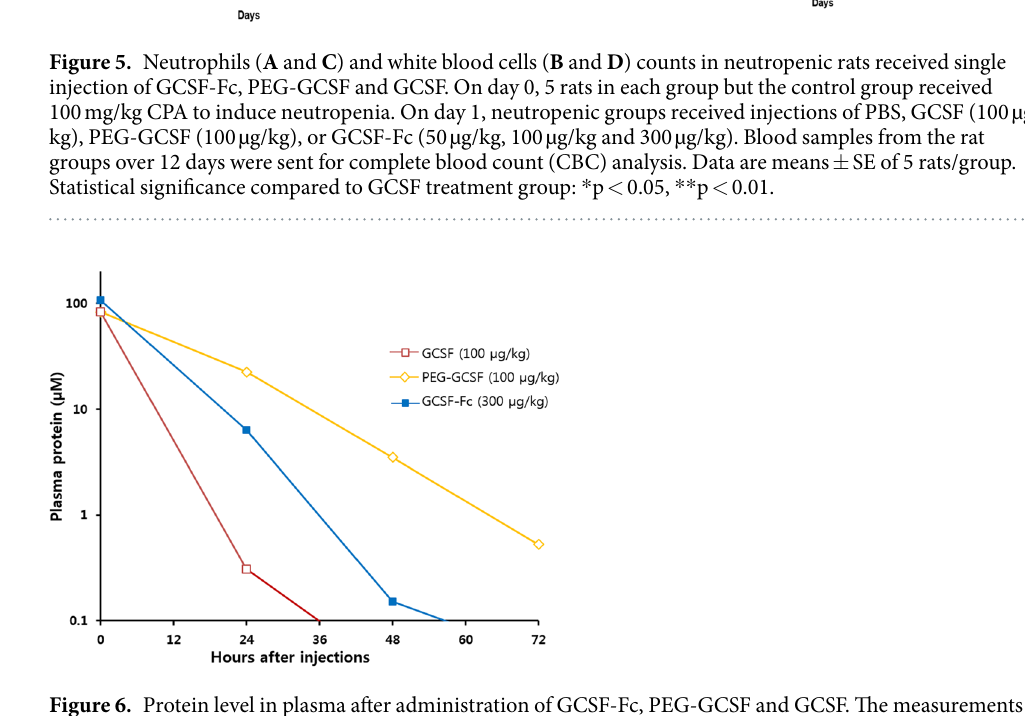
size, easy purification using MBP chromatography, and efficacy in supporting the expression as well as proper folding of target proteins in the reducing environment of E. coli cytoplasm, MBP is largely the tag of choice. For the expression of MBP-tagged GCSF-Fc, induction by 0.5 mM IPTG at 30°C for 5 h was the optimal condition for expression (Fig. 1B). Nearly 70% of this fusion protein was soluble and this maximized the purification process with only the protein A resin (Fig. 2A and B). When the Fc domain alone was expressed in E. coli BL21(DE3), multimer and soluble aggregates were formed (data not shown), which may be due to poor disulfide bond for- mation. To overcome this, MBP-tagged GCSF-Fc was expressed in the Shuffle T7 Express system to support disulfide bond formation. Shuffle T7 Express is an engineered E. coli B strain that creates an oxidizing cytoplasm